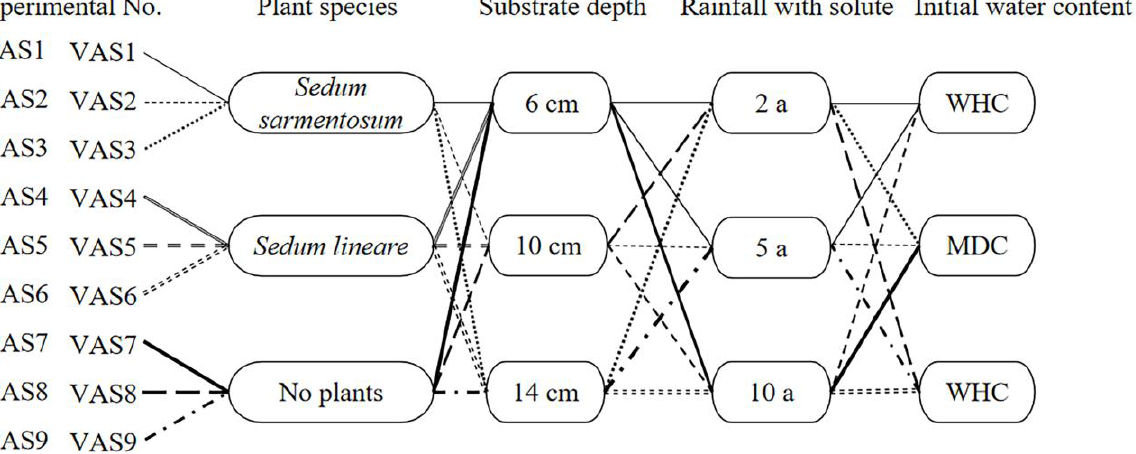
Figure 1. Orthogonal design of solute breakthrough experiments.